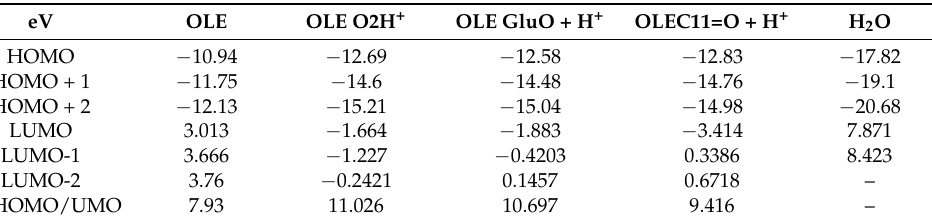
Table 1. Highest occupied molecular orbital (HOMO)/lowest unoccupied molecular orbital (LUMO) energy values of OLE and OLE + H + isomers and their ΔEs.